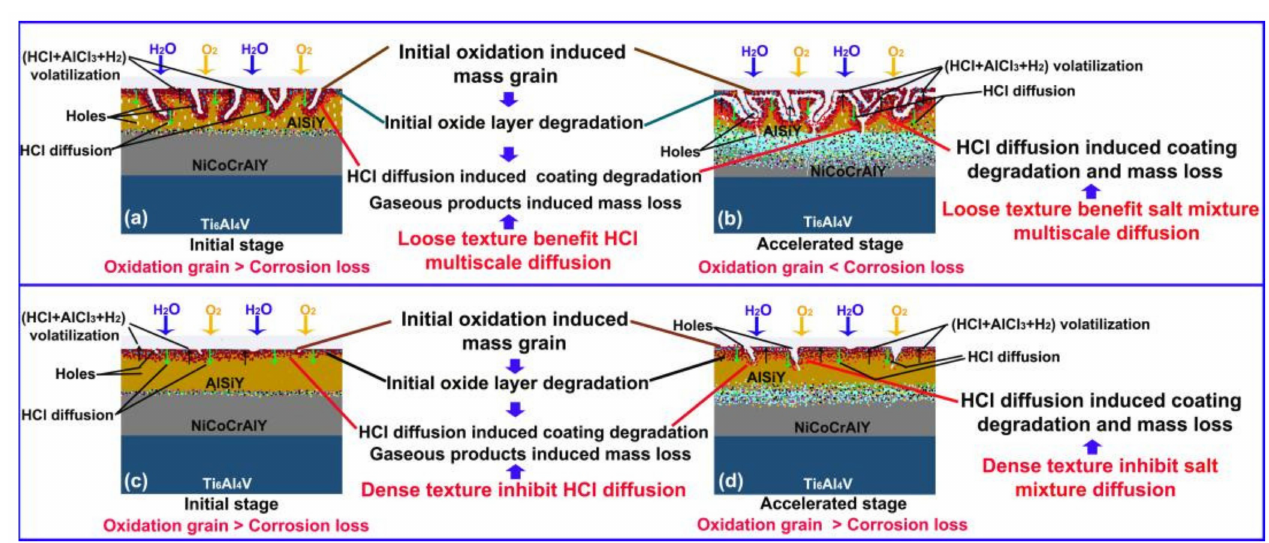
Figure 8. Schematic of hot corrosion mechanism of samples E1 ( a , b ) and E2 ( c , d